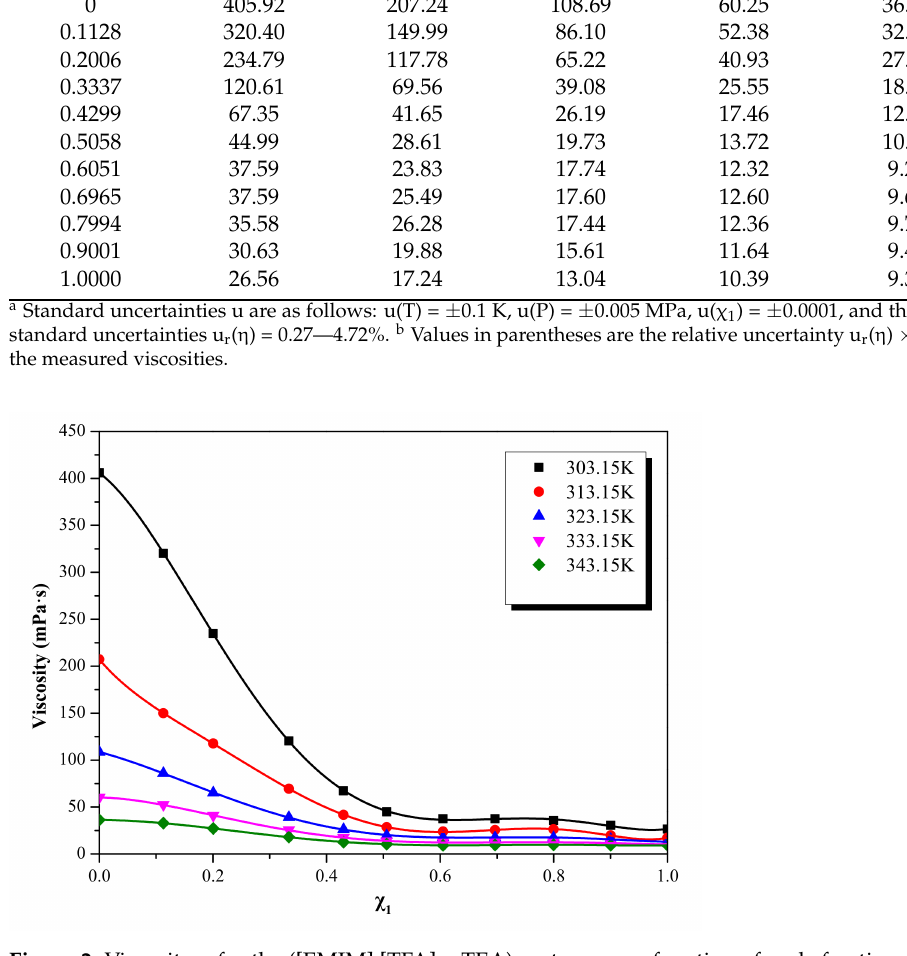
Table 2. Viscosity values of {[EMIM] [TFA]( χ 1 ) + TEA(1 − χ 1 )} binary systems (mPa · s) a,b . χ 1 303.15